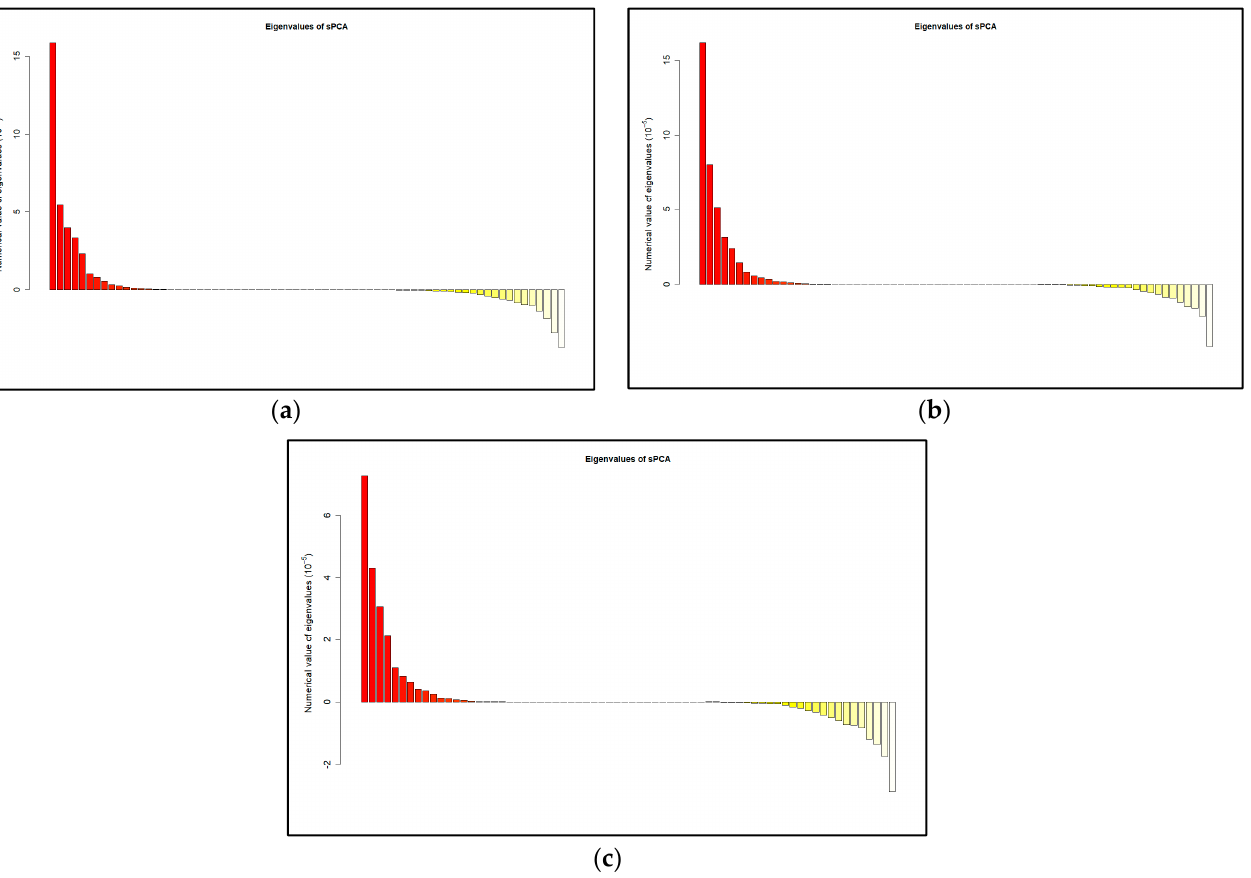
Figure 2. Distribution of eigenvalues based on FASPCA and KNN connection network: ( a ) period 1; ( b ) period 2; ( c ) period 3. Eigenvalues in red and yellow correspond to positive and negative eigenvalues respectively.